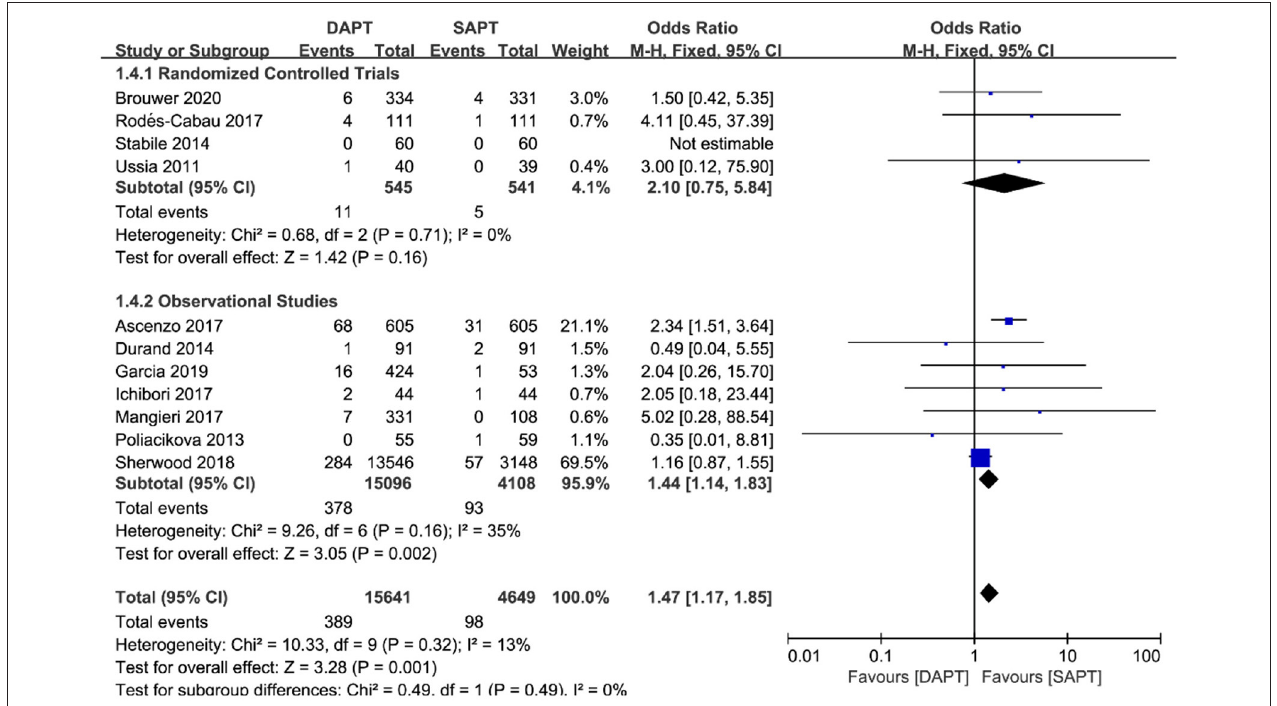
FIGURE 6 | Forest plot for myocardial infarction with subgroup analysis stratified by study type at longest follow-up.